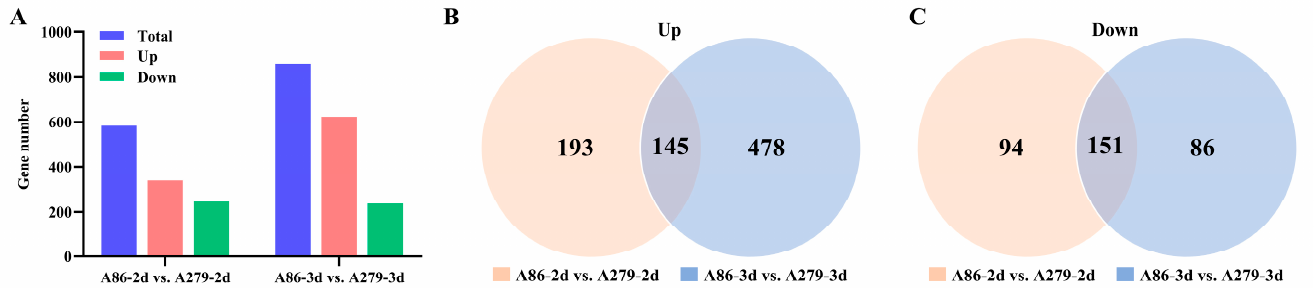
Figure 2. A summary of the DEGs. ( A ) The number of DEGs between A86 and A279 at 2 and 3 days after imbibition. Venn diagrams showing the overlap of the upregulated ( B ) and downregulated ( C ) DEGs, respectively.